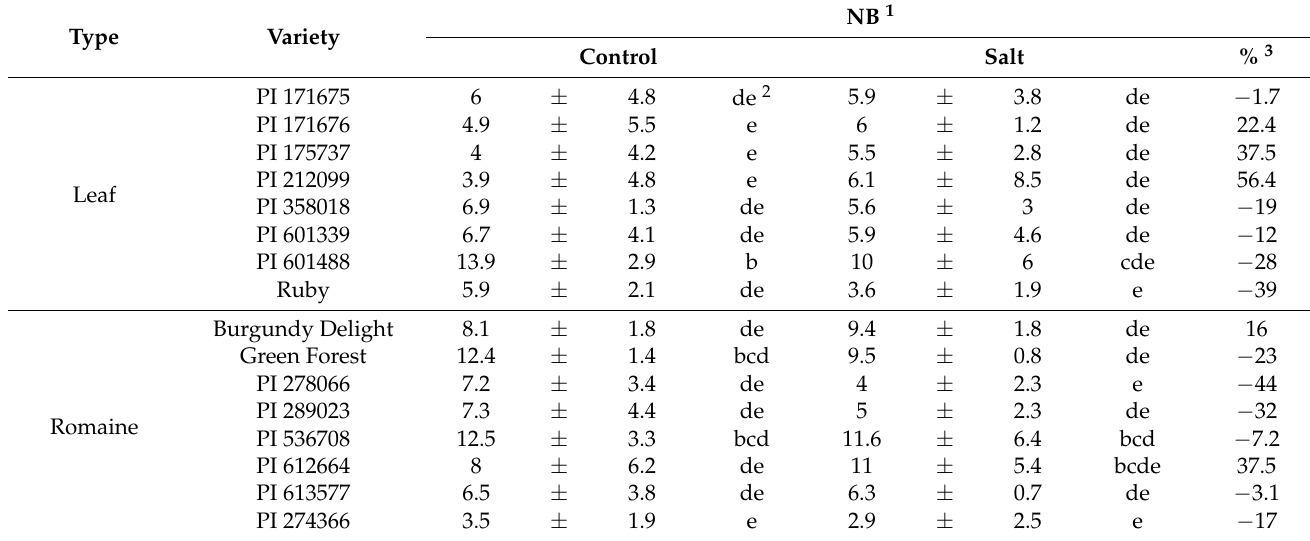
Table 12. Nitrogen balance index (NB (mean ± standard deviation, n = 4) of leaf- and romaine-type lettuce cultivars grown under control and salt-stress conditions (100 mM) after 42 days of sowing (10 days after salt